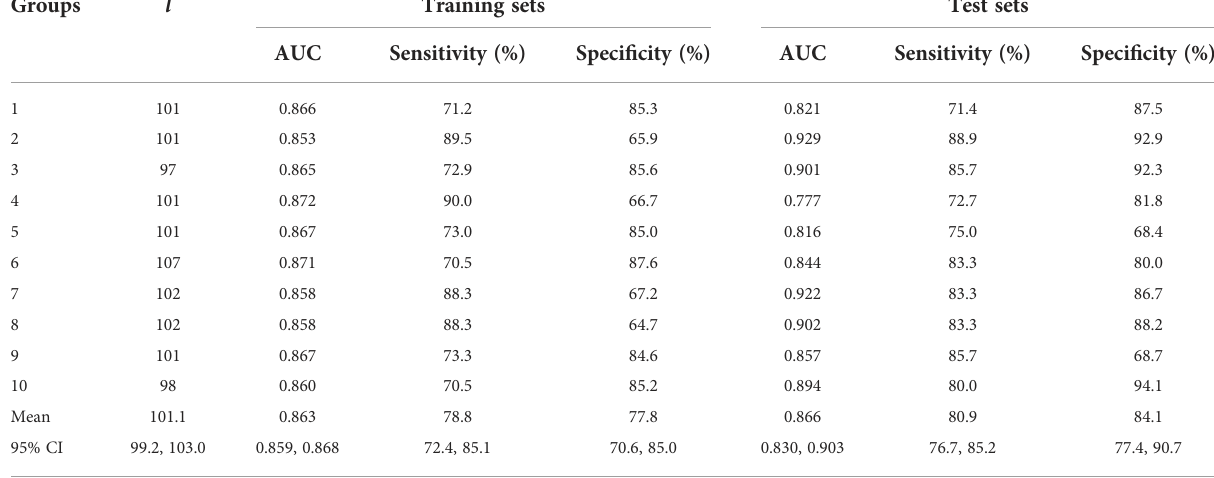
TABLE 3 Crossover-validation of performance of F d (l) in classi fi cation. Groups